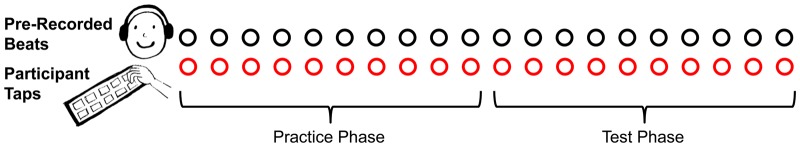
Paced Tapping Schematic.The participants practiced tapping to the sound for 20 beats (practice phase), and then immediately tapped to the sound for 20 more beats during which time their taps were recorded (test phase). The participants were asked to tap along to the beat throughout the entire task such that their taps occurred at the exact same time as the drum sounds.